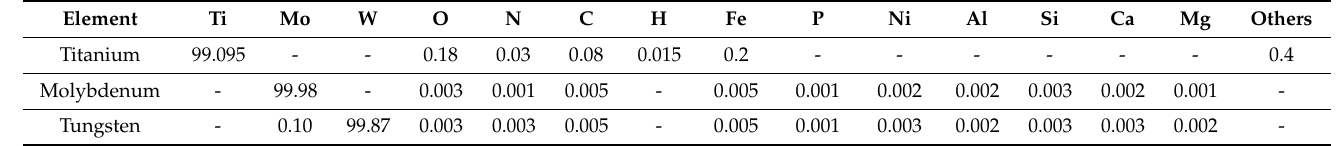
Table 1. The chemical compositions of pure metals used in the experiment